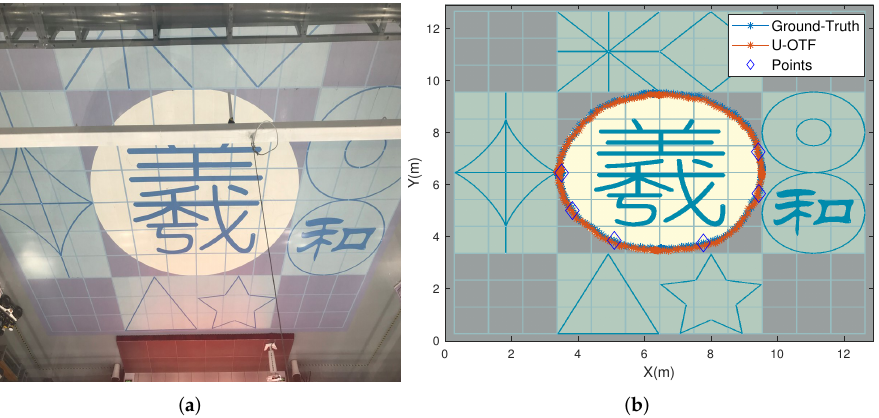
Figure 17. Moving trajectory path solution results (( a ) Test scenarios, ( b ) Test results). The Chinese characters are ground